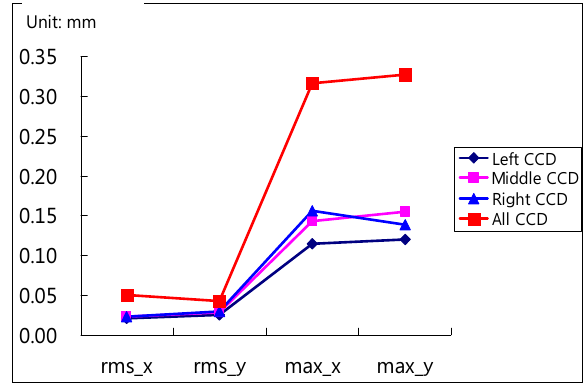
Figure 5. Image point residues of bundle block adjustment with image points from sub-images acquired by the left, middle, right TDI-CCD units and the whole image mosaic by the three sub-images 3.2 Bundle block adjustment with different combinations of IOPs